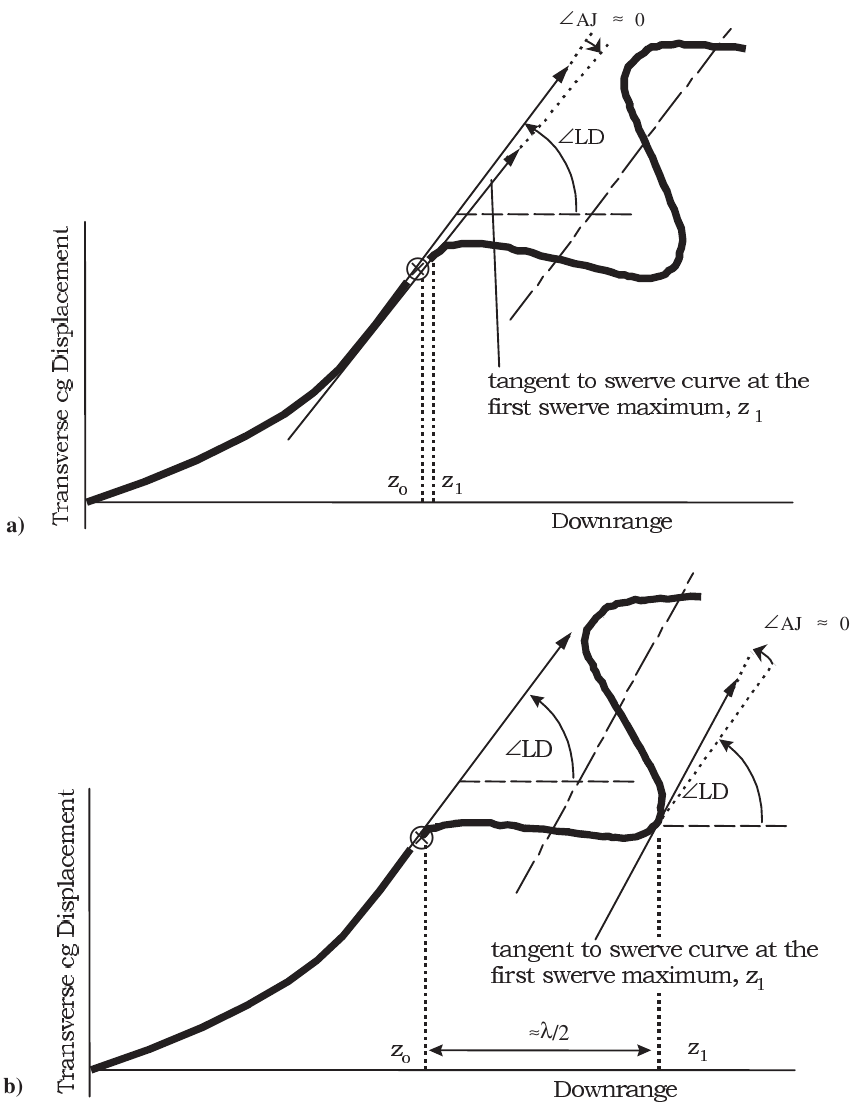
Fig. 7. The influence of initial (swerve) conditions on AJ, a) Entry into FF at z o ≈ z 1 , and b) Entry into FF at z o ≈ z 1 − λ/ 2